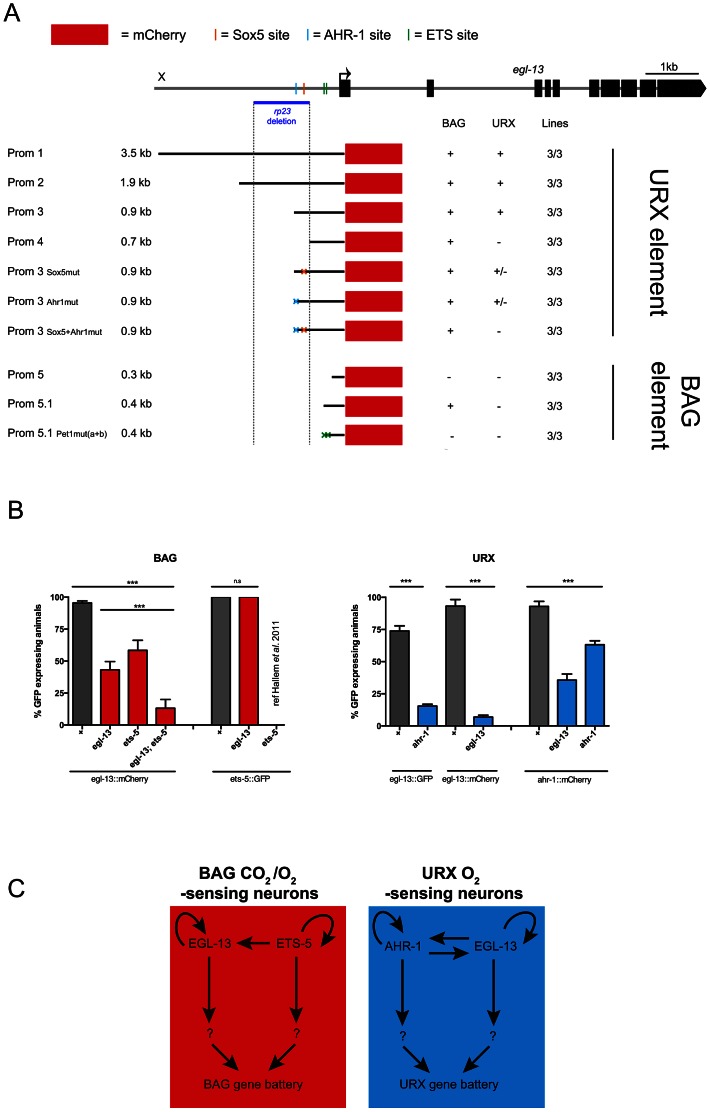
Independent regulatory modules drive egl-13 expression in O2 versus O2/CO2-sensing neurons.(A) egl-13 promoter analysis. Schematic representation of the egl-13 locus with its 3.5 kb upstream region. The ATG codon is marked with an arrow and the exons are represented as black blocks. The upstream region deleted in the rp23 allele is indicated with a blue horizontal line and a grey dashed vertical line. Below is a representation of cloned and injected constructs, and their expression pattern in the URX and BAG neurons. Black lines denote the promoter fragment placed in front of mCherry fluorescent protein (red boxes). Orange, blue and green crosses represent mutated Sox5, AHR-1 and ETS binding sites respectively. “+” indicates consistent reporter expression in at least 50% of animals in all lines. “+/−” indicates less than 50% of animals expressing the reporter in all lines. “−” indicates loss of expression. Three independent transgenic lines were analyzed for each promoter as indicated. (B) Expression of egl-13 and ets-5 reporter transgenes in the BAG neurons in the reciprocal mutant backgrounds (left). egl-13(ku194) and ets-5(tm1734) alleles were used. Expression of egl-13 and ahr-1 reporter transgenes in the URX neurons in the reciprocal mutant backgrounds (right). egl-13(ku194) and ahr-1(ia3) alleles were used. n>50 per strain. Error bars represent the standard error of the mean (SEM) **P<0.05, ***P<0.005. (n.s.) indicates no significant difference from wild-type. See materials and methods for neuronal scoring criteria used. (C) In the BAG neurons (left), the ETS transcription factor, ETS-5 regulates the expression of egl-13 in the BAG neurons via conserved ETS binding sites located in the egl-13 promoter. In addition, egl-13 and ets-5 autoregulate in the BAG neurons to generate BAG fate. In the URX neurons (right), egl-13 and ahr-1 autoregulate, in addition to regulating the expression of each other. Other unknown factors act in parallel to and in combination with these factors to drive BAG and URX neuronal fate.